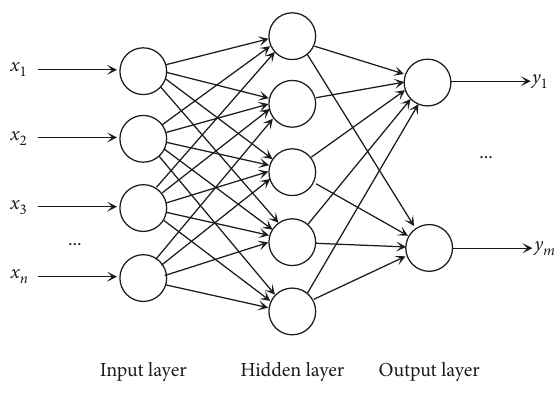
Figure 1: The architecture of back-propagation neural